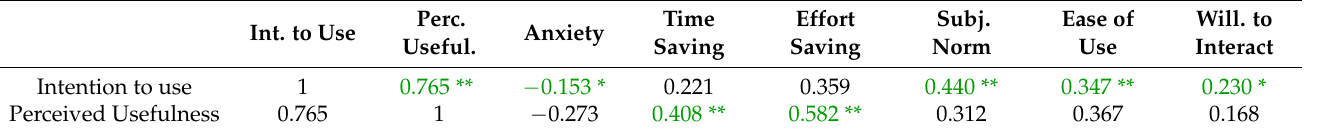
Table 5. Results of Pearson’s correlation analysis on the dataset. If ** is indicated, the correlation is significant at the 0.01 level. If * is indicated, the correlation is significant at the 0.1 level. Int. to